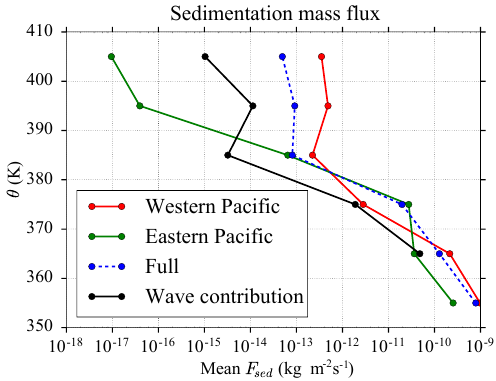
Figure 7. Sedimentation water flux F sed estimated from ATTREX observations in the eastern Pacific 2013 observations, western Pa- cific and for the whole campaign as a function of potential tempera- ture. The wave stability impact is illustrated for the whole campaign by the black curve, which corresponds to the wave contribution to (cid:12) (cid:16) ∂θ (cid:48) (cid:17) (cid:12) (cid:12) (cid:12) F sed / ∂θ the flux (cid:12) (cid:12) . In the upper part of the TTL the wave ∂z ∂z stability impact reduces the sedimentation flux by about 10% of the total